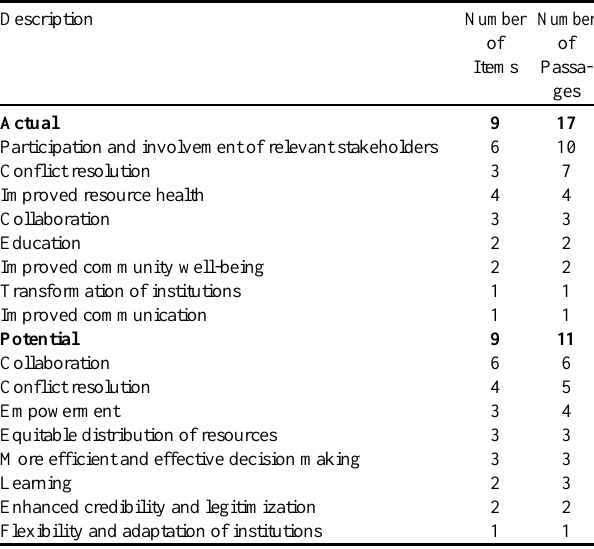
Table 5. Successes of adaptive comanagement